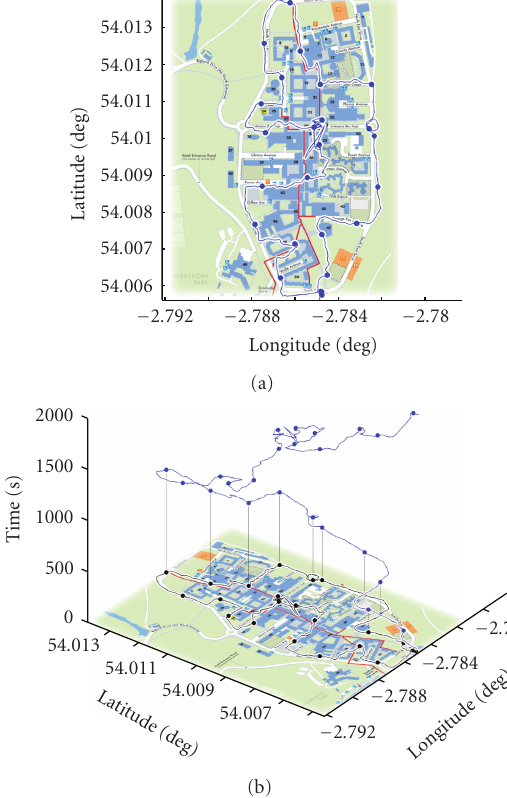
Figure 1: 2D path and 3D space-time path of a journey around Lancaster University campus (7th of April 2007).